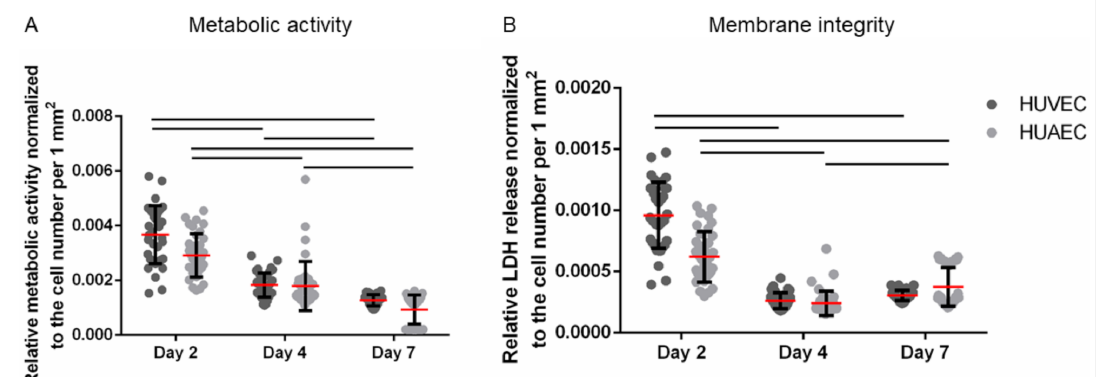
Figure 3. Metabolic activity ( A ) and membrane integrity ( B ) of endothelial cells. Human umbilical cord-derived endothelial cells from veins (HUVEC) or arteries (HUAEC) were seeded at a density of 15,000 cells/well at day 0 and cultivated for 2, 4, and 7 days. The metabolic activity and membrane integrity were normalized to the number of vital adherent cells per mm 2 leading to decreasing values over time. Straight black lines indicate p ≤